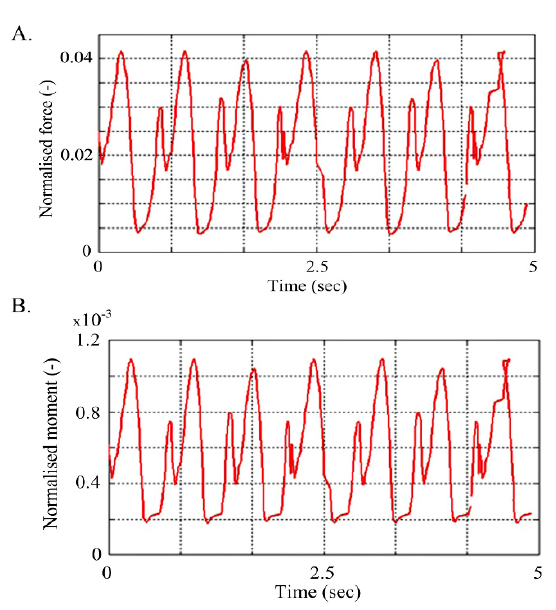
Figure 6. A. The diagram of normalized muscle force; B. The diagram of normalised muscle moment of the musculus gastrocnemius medialis of a healthy subject.